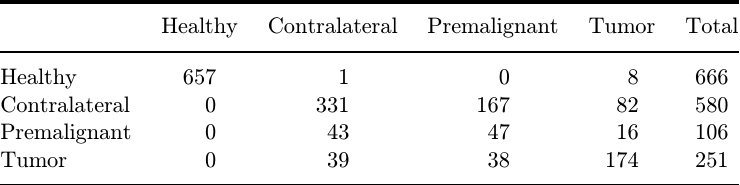
Table 9. PC-LDA for e±ciency of RS in identifying healthy, contralateral, premalignant and tumor conditions at pooled